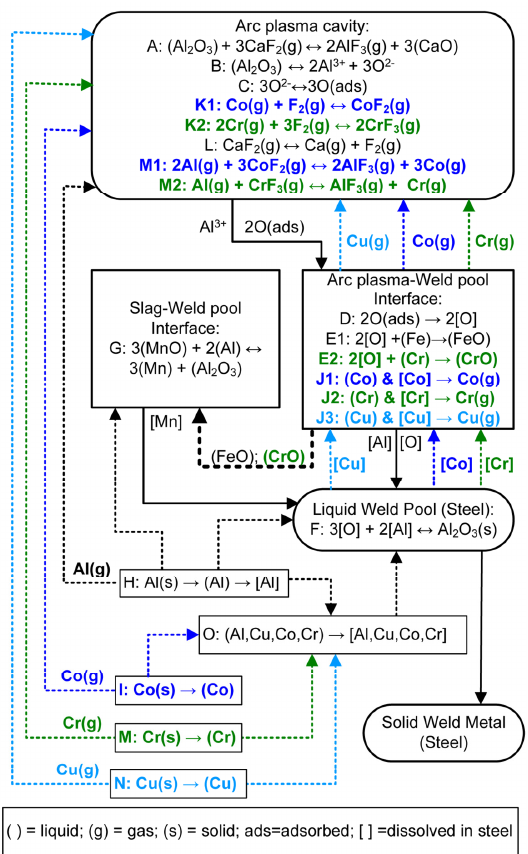
Figure 11. SAW reaction flow diagram with Al, Cr, Co and Cu powder additions.